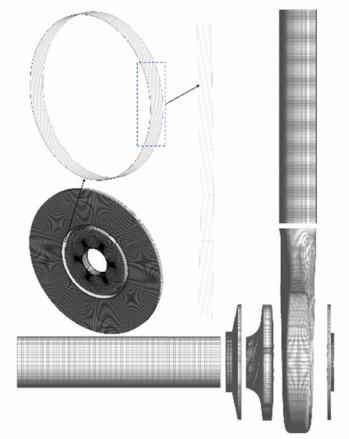
Figure 3. The grid of the centrifugal pump.